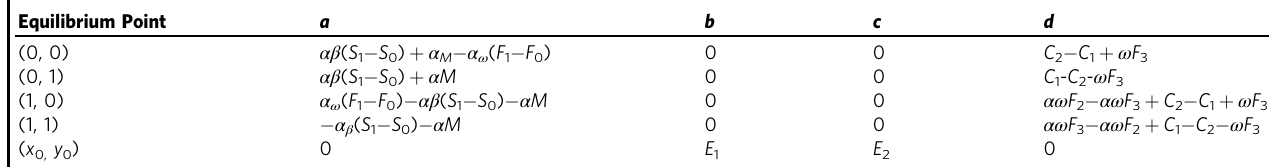
Table 2 The values corresponding to the local equilibrium points of the evolutionary game. Equilibrium